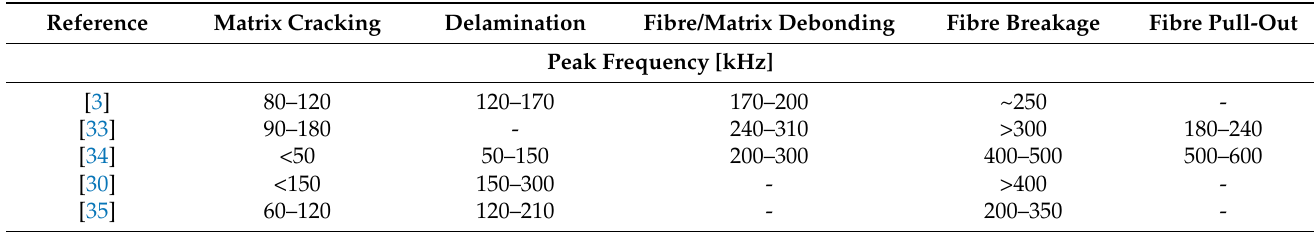
Table 1. Peak frequencies of AE signals (in kHz) for different failure mechanisms in CFRP composites (the results are obtained with a WD sensor).